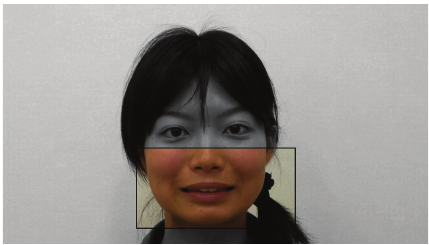
Figure 4: The mouth region of the stimuli: the stimuli started only when participants fixate within the black frame for at least 500 ms in Experiment